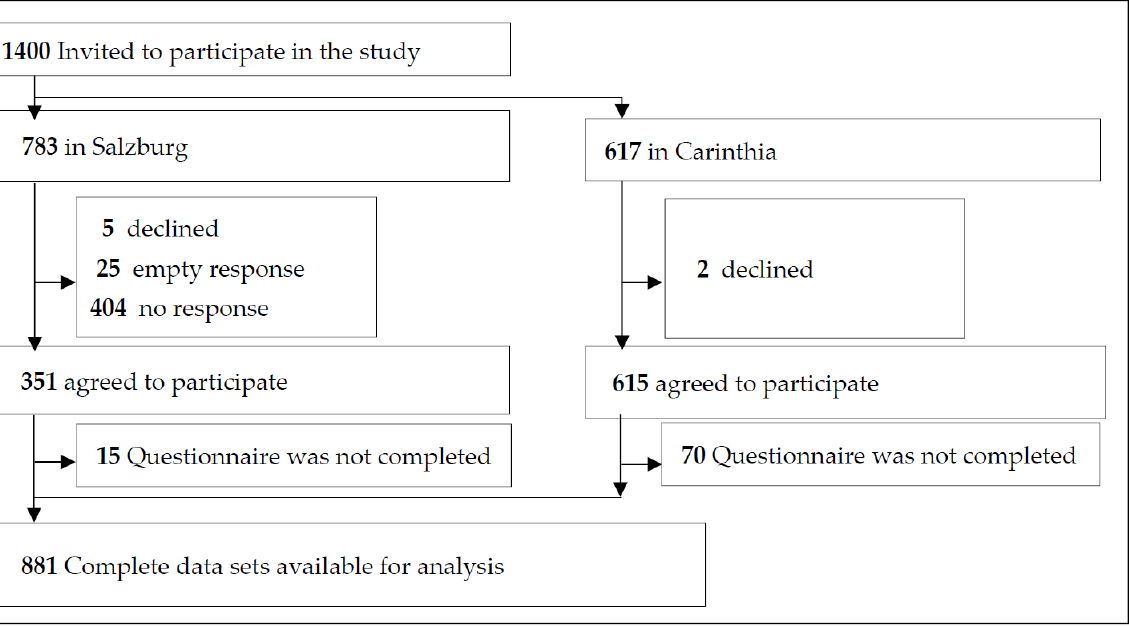
Figure 1. Study flow diagram.